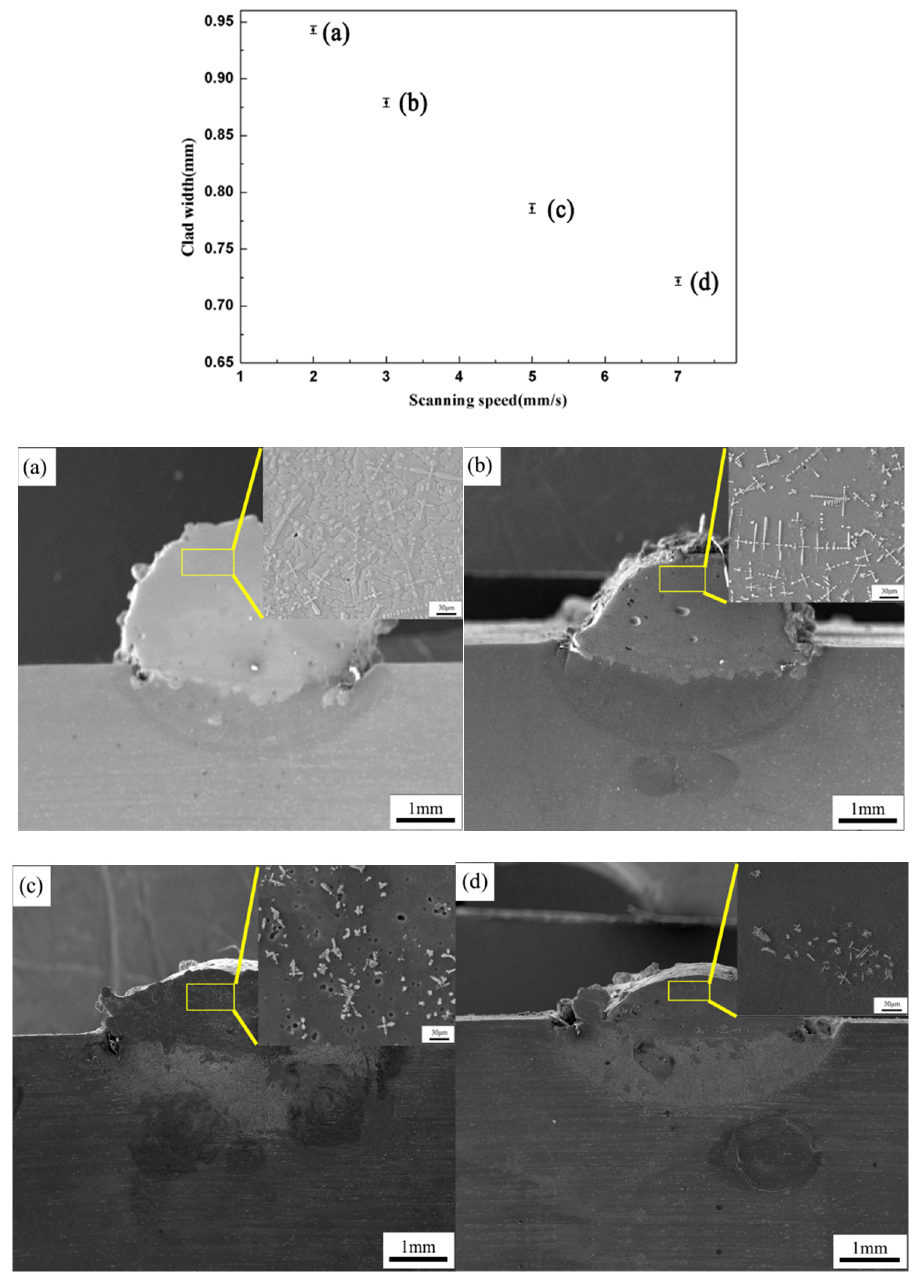
Figure 5. The effect of different scanning speeds on the clad width and microstructure in different scanning speed (S). ( a ) the scanning speed of 2 mm/s; ( b ) the scanning speed of 3 mm/s; ( c ) the scanning speed of 5 mm/s; ( d ) the scanning speed of 7 mm/s.